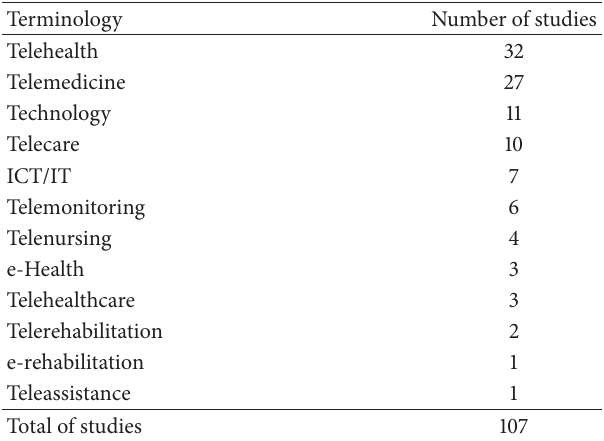
Table 3: Number of studies per